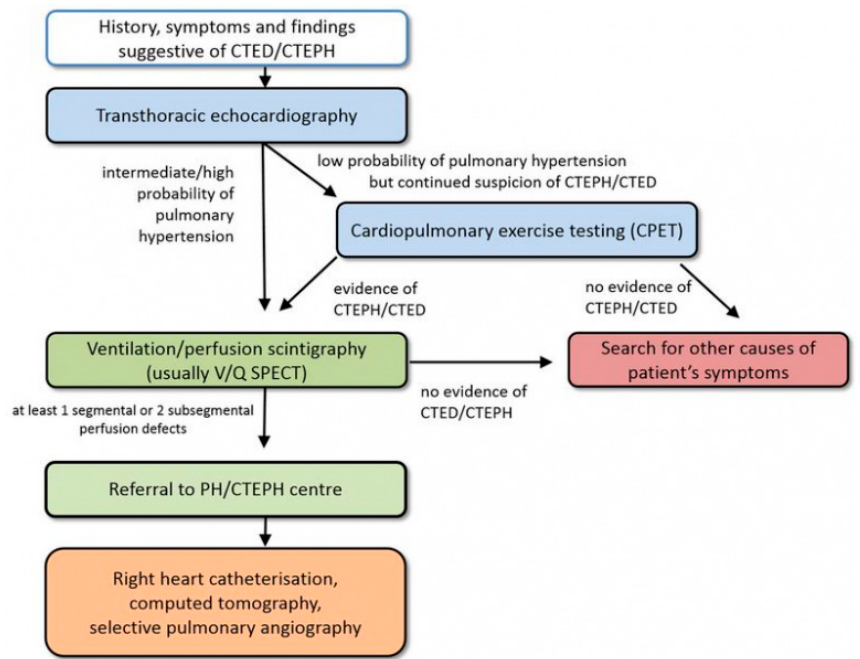
Figure 1. CTEPH diagnostic algorithm. Adapted from Wikens H, Ulrich S, consensus conference Cologne, 2016. CTED = chronic thromboembolic pulmonary vascular disease; CTEPH = chronic thromboembolic pulmonary hypertension; PH = pulmonary hypertension [9]. Reproduced with